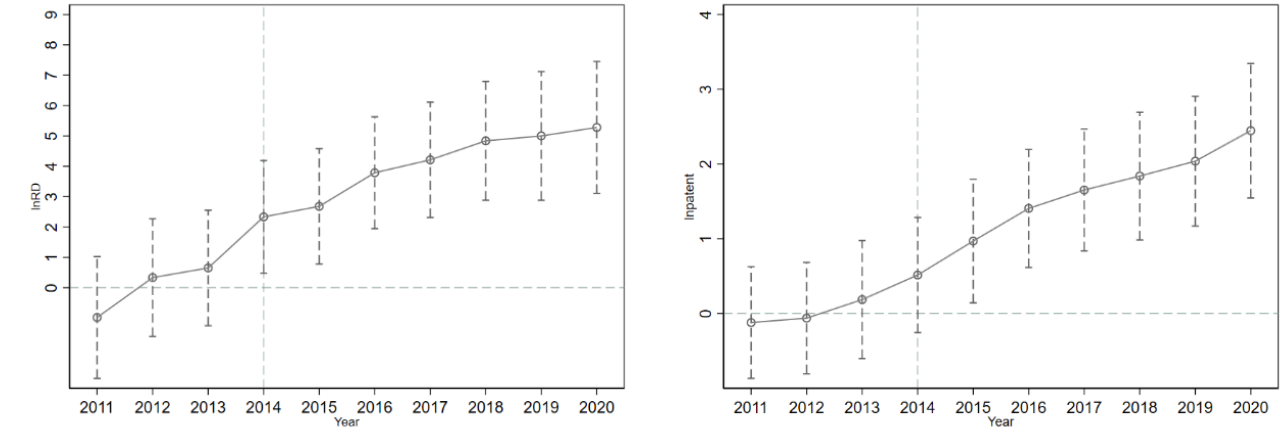
Figure 7. Parallel trend and dynamic effect in enterprise R&D technological innovation.